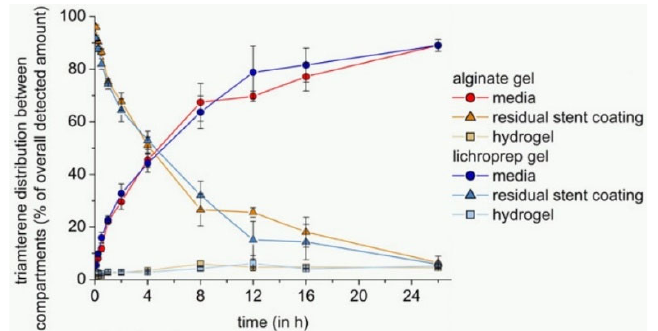
Figure 9. Comparison of reference and modified hydrogels. Alginate gel versus LiChroprep gel con ‐ taining 5% w / w LiChroprep ® RP ‐ 18. Cumulative amounts (%) of triamterene detected in PBS pH 7.4, respective gel formulations, and residual model substance fractions within the stent coating, re ‐ printed from [64].